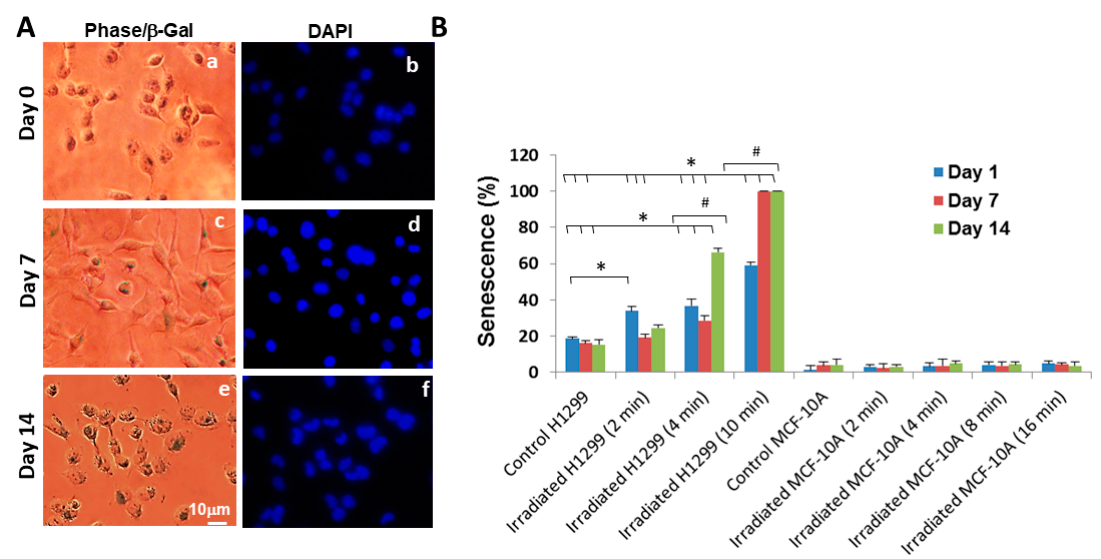
Figure 5. ( A ) Senescence effect following 4 min of W-band (75–105 GHz) MMW treatment on H1299 cell line. Scale bars correspond to 10 μ m. ( B ) The number of cells were counted for each group was 400–550. Each experiment was repeated four times. * and # indicates p -values of <0.05 and <0.01 respectively. Table 5. Summary of the mortality effect following W-band (75–105 GHz) MMW treatment on H1299 and MCF-10A cell lines .